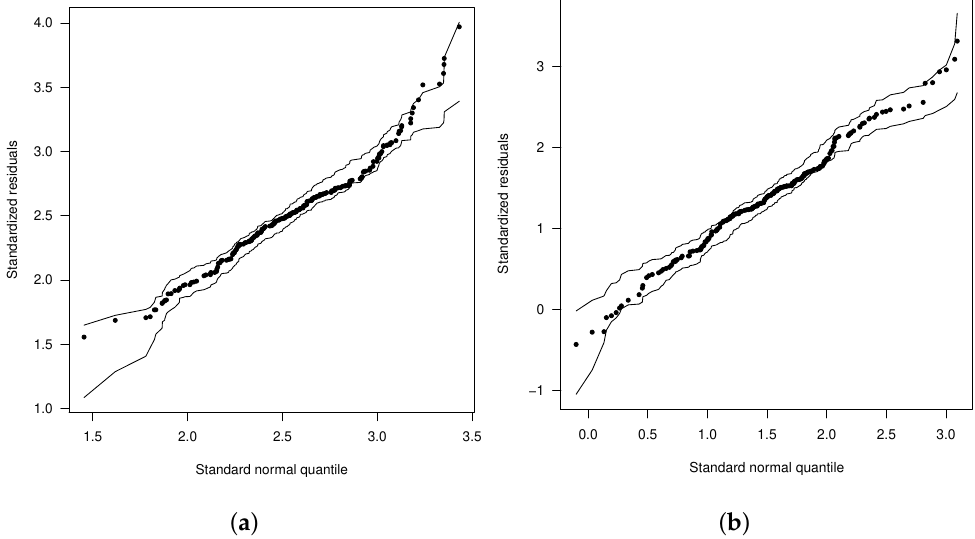
Figure 3. Envelope graphics for r MT